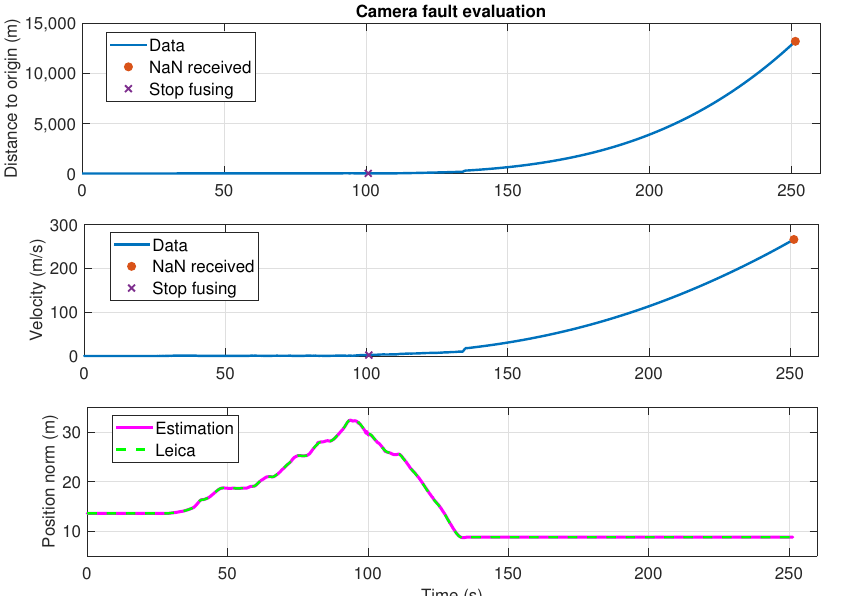
Figure 10. Camera fault evaluation. On top, the measured distance to the origin. In the middle, the velocity norm estimated by the T265 camera algorithm. At the bottom, the position norm, for both our system estimation and the Leica